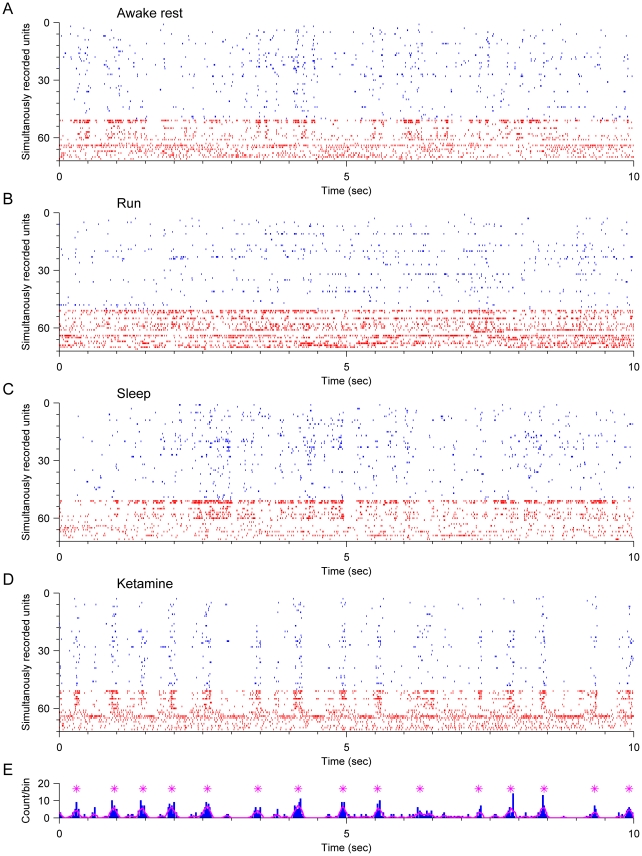
Hippocampal ensemble firing pattern changes after ketamine injection.(A–E) The spike raster plots show the activities of simultaneously recorded hippocampal neurons when the animal was asleep (A), awake resting (B), running (C), anesthetic state after ketamine injection (D), and recovery from ketamine (E). Each short vertical bar indicates a single spike, and each line indicates a single unit recorded. Pyramidal cells are shown in blue, and interneurons are shown in red. After ketamine injection, the population firing pattern has changed dramatically. Note the vertical alignments of spikes indicating the synchronous firing of pyramidal cells (D).